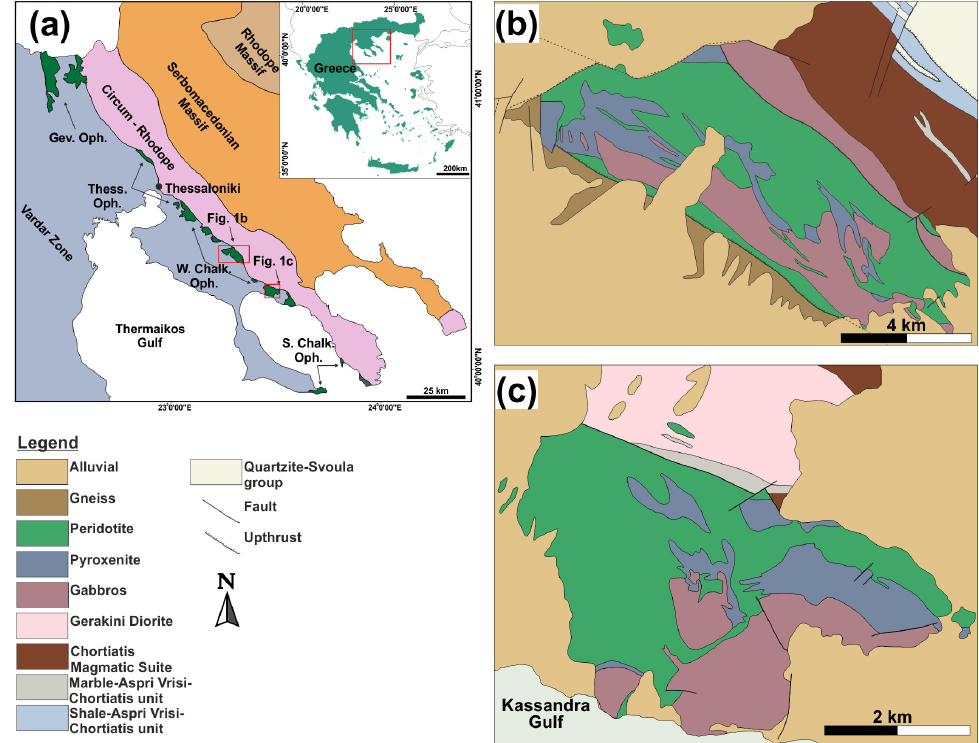
Figure 1. ( a ) Innermost Vardar Zone ophiolites: Geuvgeli complex (Gev. Oph.), Thessaloniki ophiolites (Thess. Oph.), West Chalkidiki ophiolites (W. Chalk. Oph.) and South Chalkidiki ophiolites (S. Chalk. Oph.); ( b ) Vavdos ophiolite; ( c ) Gerakini-Ormylia ophiolite. ( b , c ) are modified after Poliyiros and Arnaia sheets of the Hellenic Survey of Geology and Mineral Exploration (HSGME).